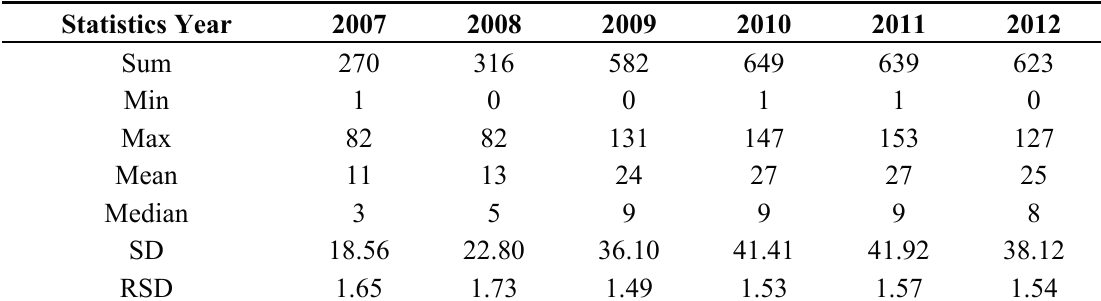
Table 2. Statistics on respiratory outpatients from 2007 to